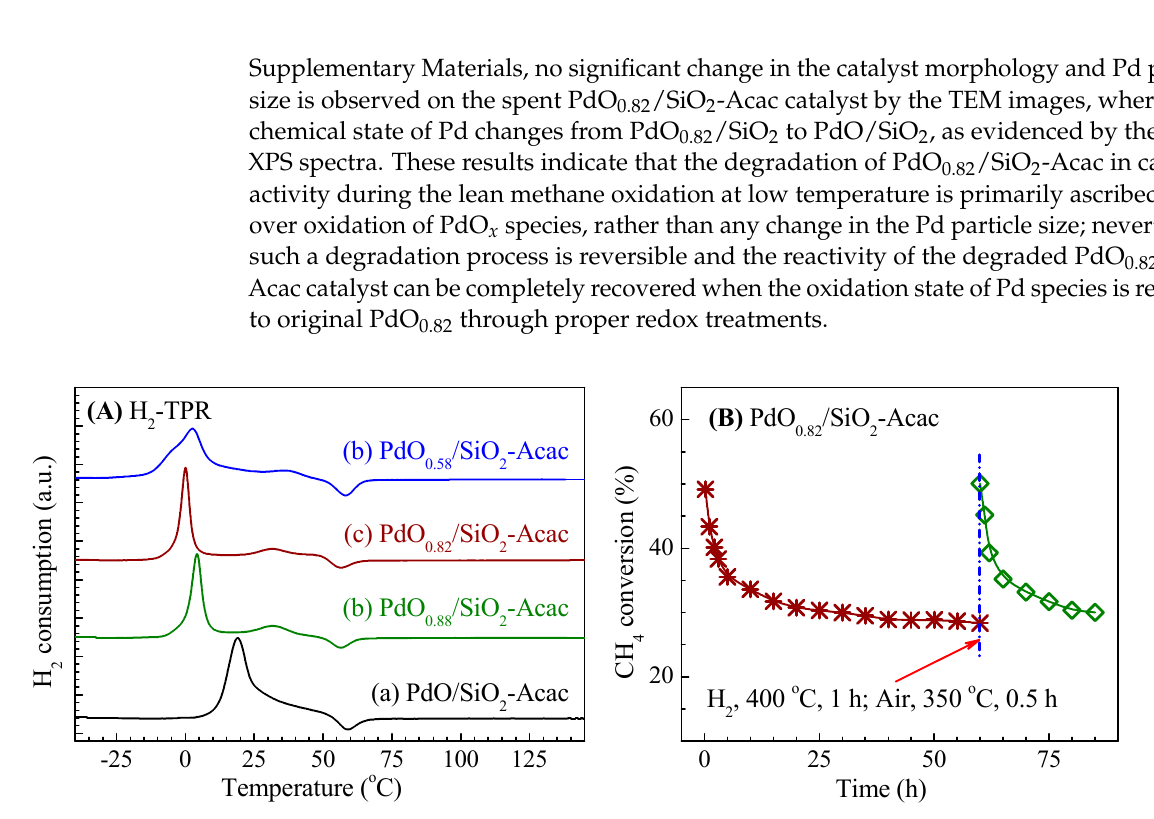
Figure 5. ( A ) H 2 -TPR profiles of ( a ) PdO/SiO 2 -Acac; ( b ) PdO 0.88 /SiO 2 -Acac; ( c ) PdO 0.82 /SiO 2 -Acac; ( d ) PdO 0.58 /SiO 2 -Acac. ( B ) Methane conversion versus reaction time over the PdO 0.82 /SiO 2 -Acac catalyst; after reaction for 60 h, the catalyst is subjected to a reduction treatment in hydrogen at 400 ◦ C for 1 h and oxidation treatment in air at 350 ◦ C for 0.5 h and then re-tested for lean methane oxidation. The reactions were conducted at 280 ◦ C with the feed of 1 vol.% CH 4 and 99 vol.% air and a GHSV of 30,000 mL h − 1 g − 1 .